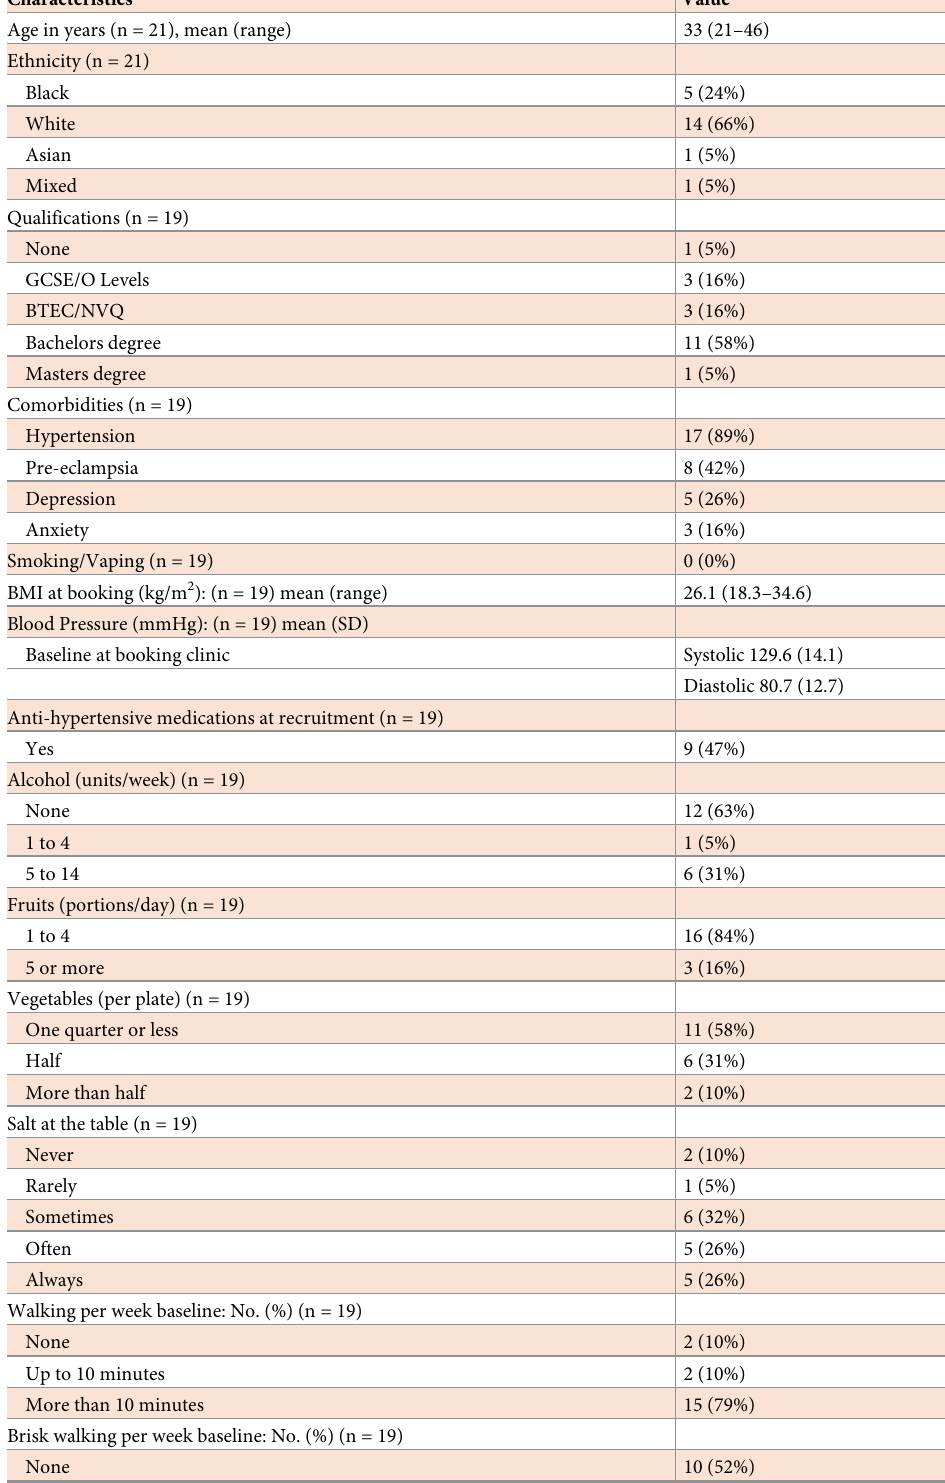
Table 1. Demographic and clinical characteristics of 21